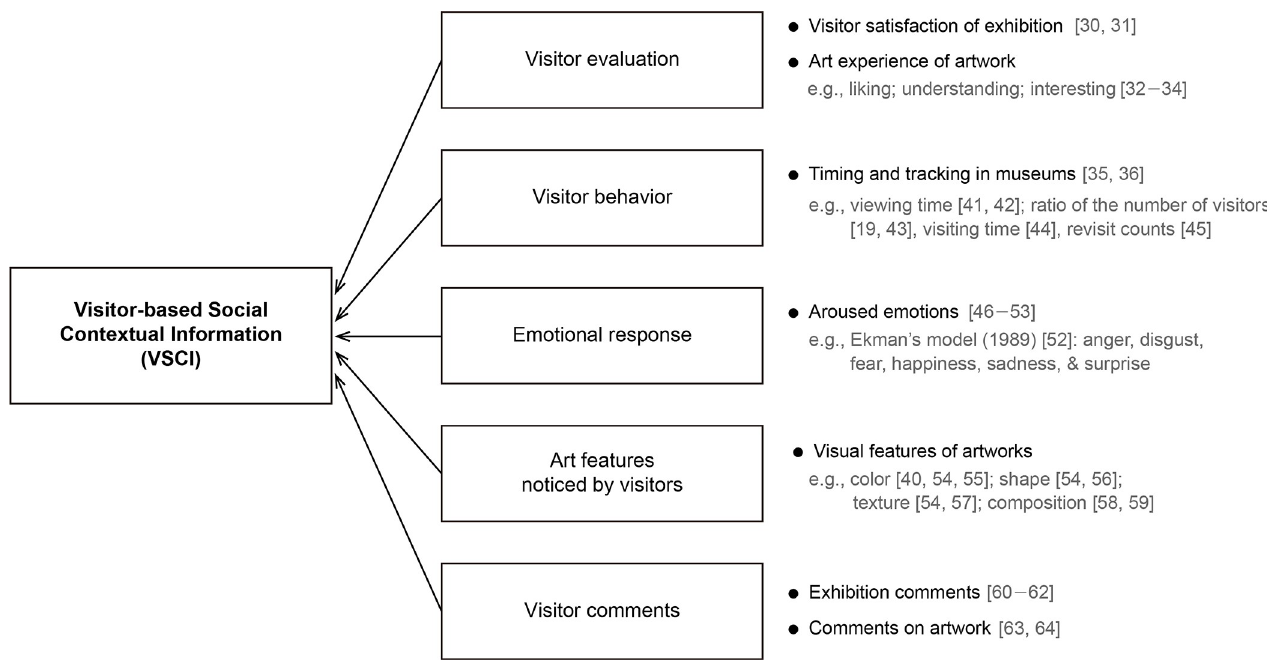
Fig 1. Conceptual framework of VSCI based on previous visitor